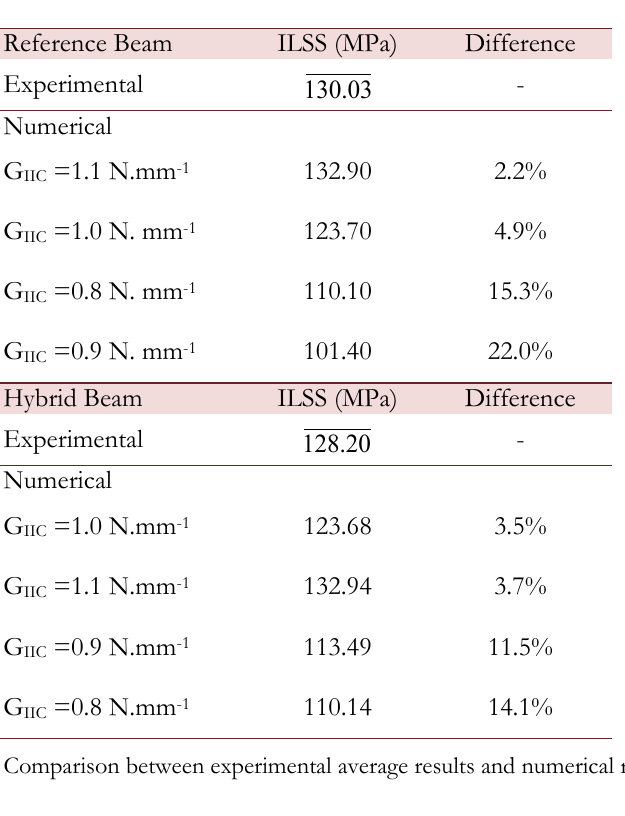
Figure 9: Hybrid beam. Comparison between numerical and experimental results (specimen